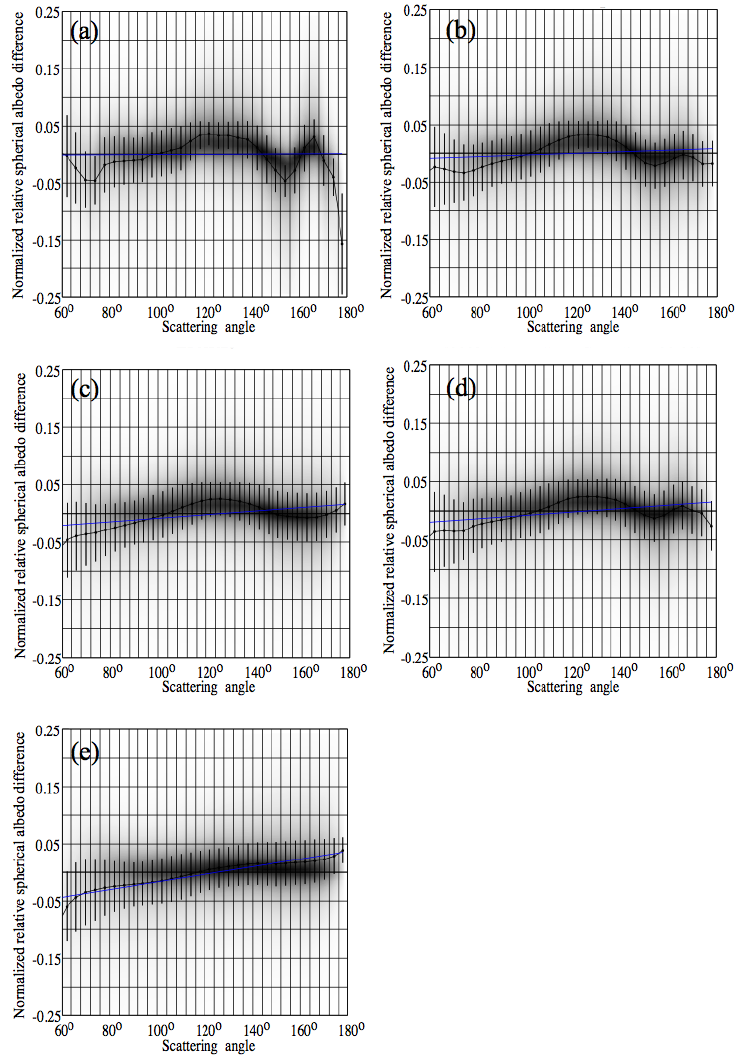
Figure 8. SAD analysis of the ensemble ice particle model with D eff = 60µm for various distortions: (a) no distortion applied; (b) with distortion value of 0.15; (c) with distortion value of 0.25; (d) averaged over all distortion values; (e) distortion value of 0.4 is assumed with spherical air